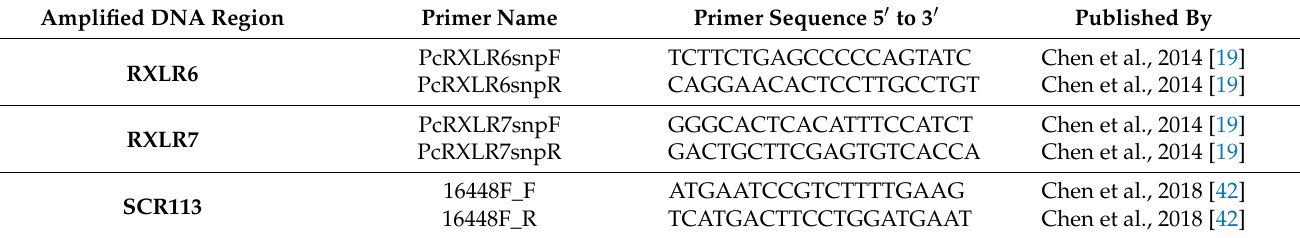
Table 2. List of primers used in amplification of effector genes DNA sequences. Amplified DNA